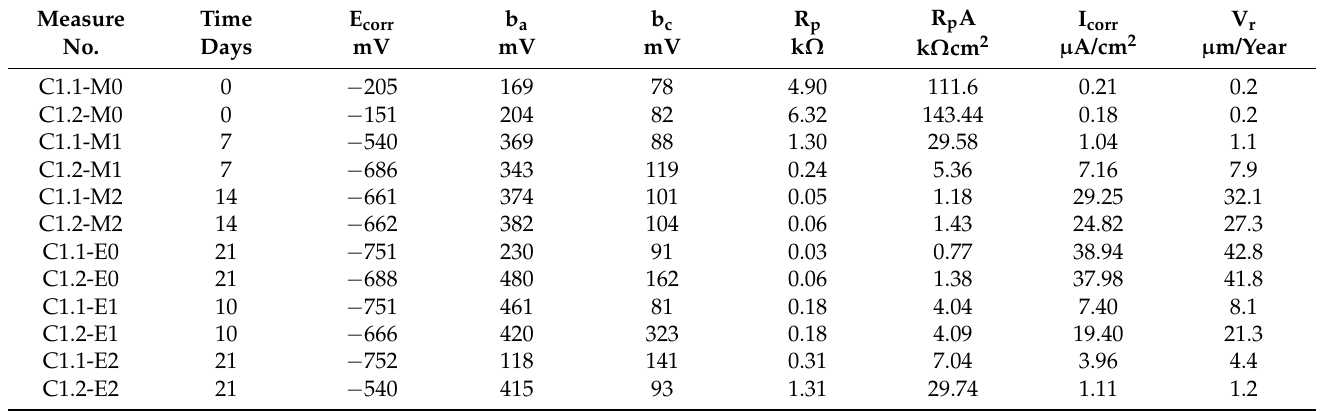
Table A1. Comparison of results from analyzing polarization curves obtained for two selected specimens C1.1 and C1.2 measuring before (M0) and after 7 (M1) and 14 (M2) and 21 (E0) days chloride migration and after 10 (E1) and after 11 (E2) days chloride extraction.